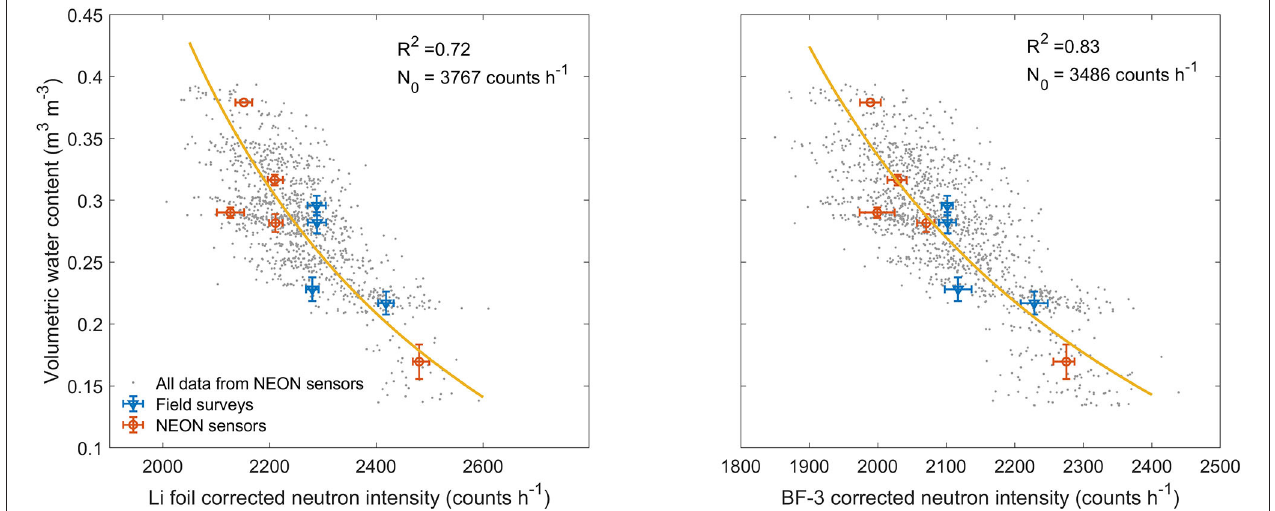
FIGURE 4 | Calibration curve of the Li foil (left) and BF-3 (right) systems. The calibration was accomplished using the average volumetric water content in the 0–12cm soil layer of four field surveys and five additional points of average volumetric water content obtained from a transect of five soil moisture sensors located across the NEON KONA site. The volumetric water content of the NEON sensors is the average of the sensors at 5 and 15cm depth. All observations of volumetric water content from the NEON sensors were added in the background to show the variability of the data but were not included in the curve fitting exercise. Mean neutron counts for each calibration point are the arithmetic average of a 12h period of corrected unfiltered neutron intensities. Error bars represent